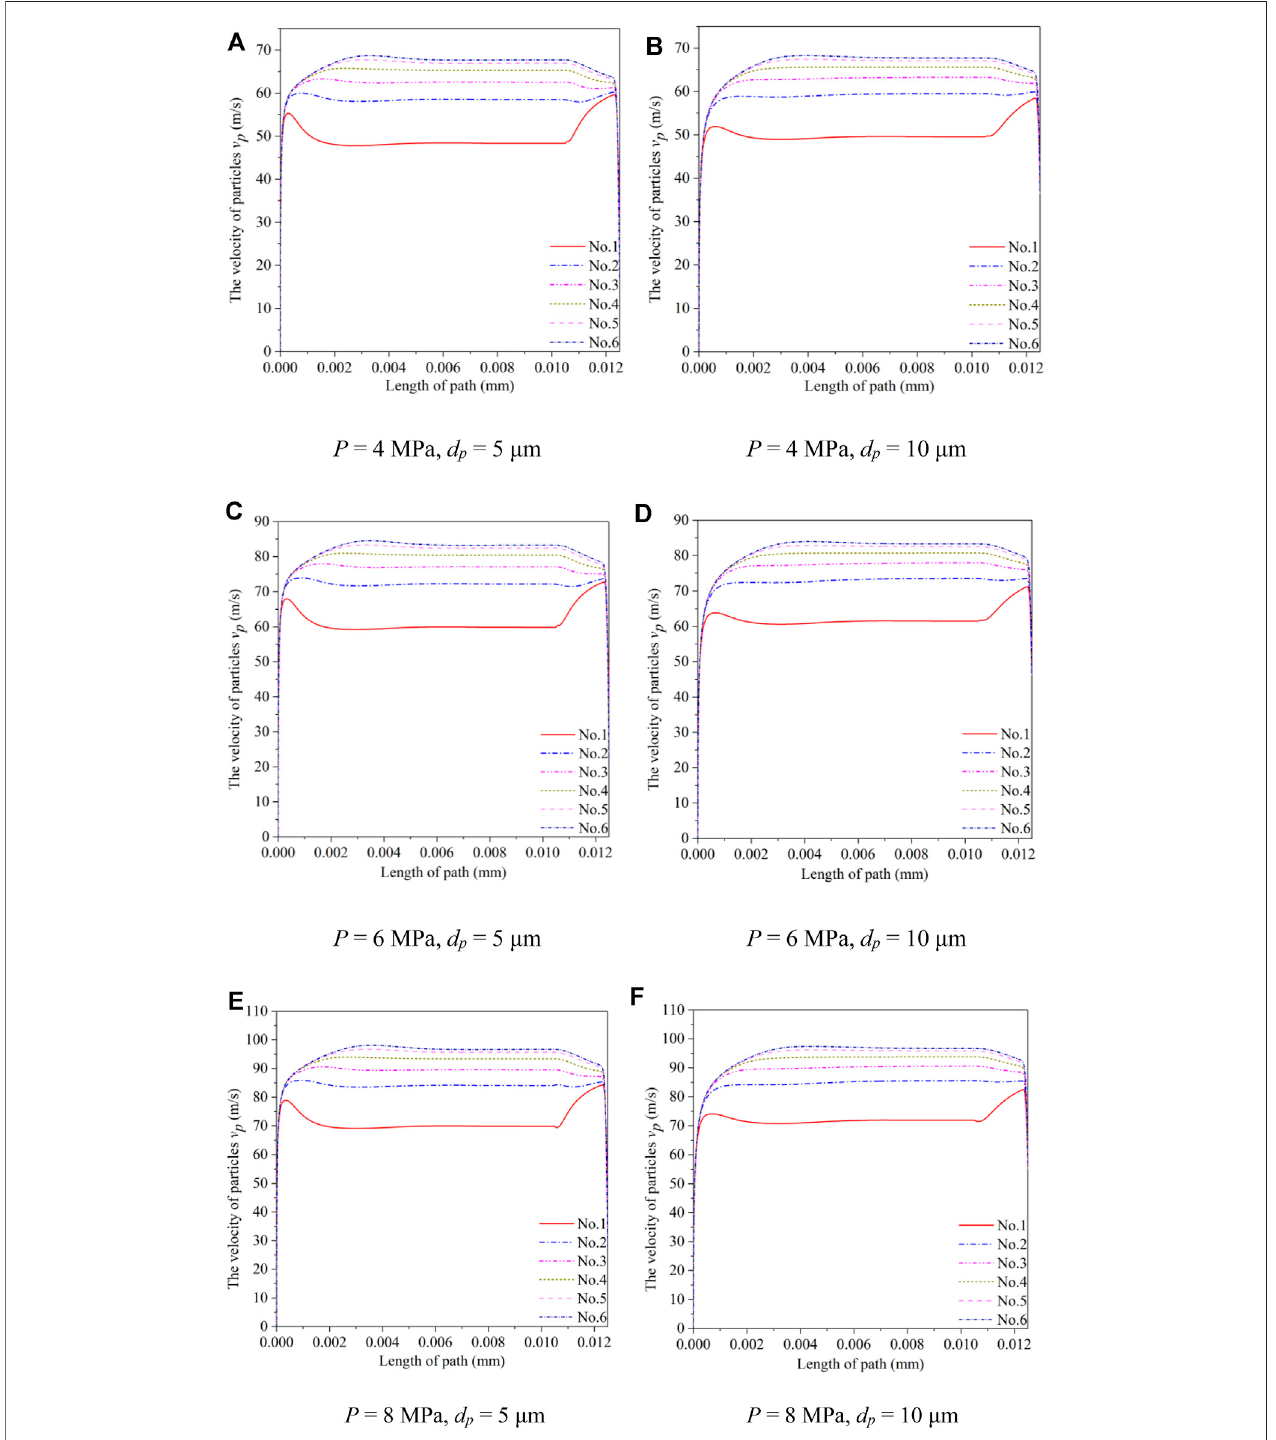
FIGURE6| Velocitychangesofabrasiveparticlesofdifferentsizesinthe fl ow fi eldalongthemovementpath. (A) P =4 MPa, d p =5 μ m, (B) P =4 MPa, d p =10 μ m, (C) P = 6 MPa, d p = 5 μ m, (D) P = 6 MPa, d p = 10 μ m, (E) P = 8 MPa, d p = 5 μ m, (F) P = 8 MPa, d p = 10 μ m.